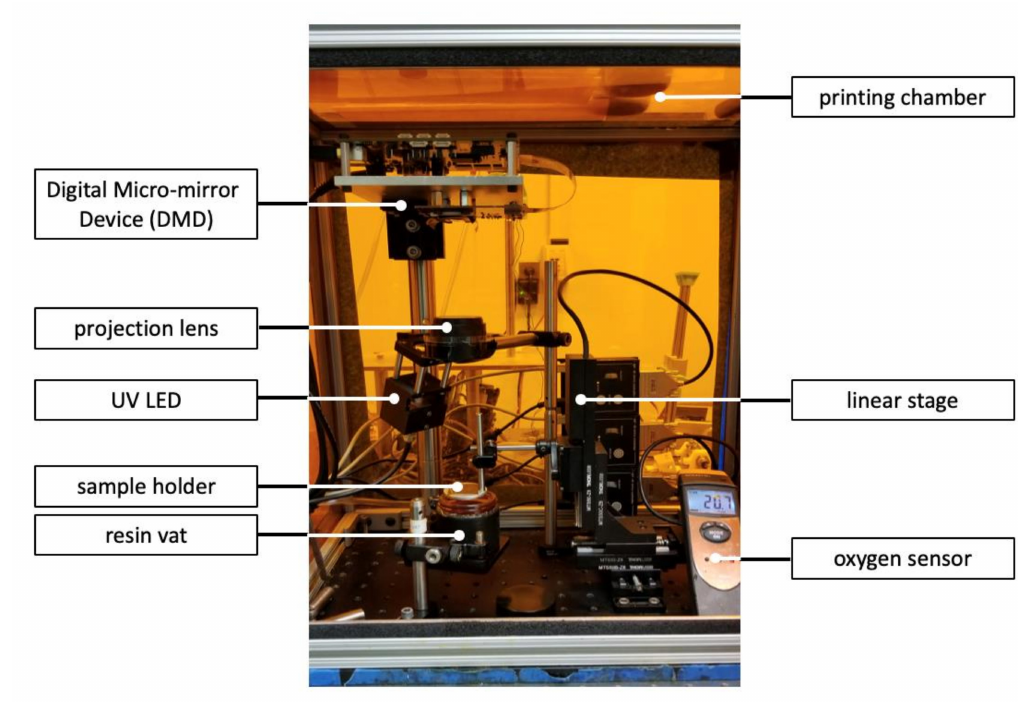
Figure 2. P µ SL experimental